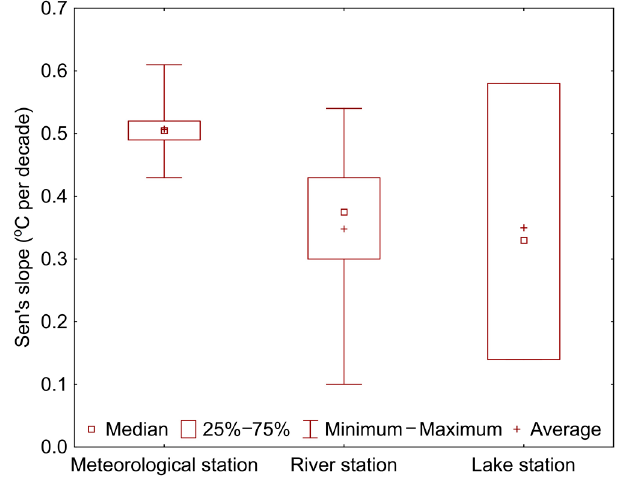
Figure 6. The ranges of mean annual changes in air and water temperatures in rivers and lakes.